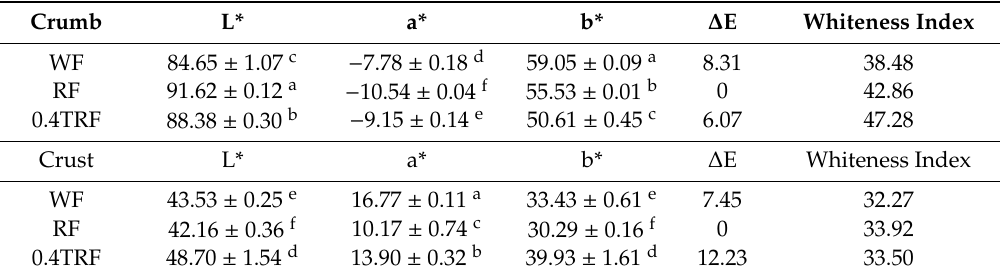
Table 3. Color of gluten-free cake crumb and